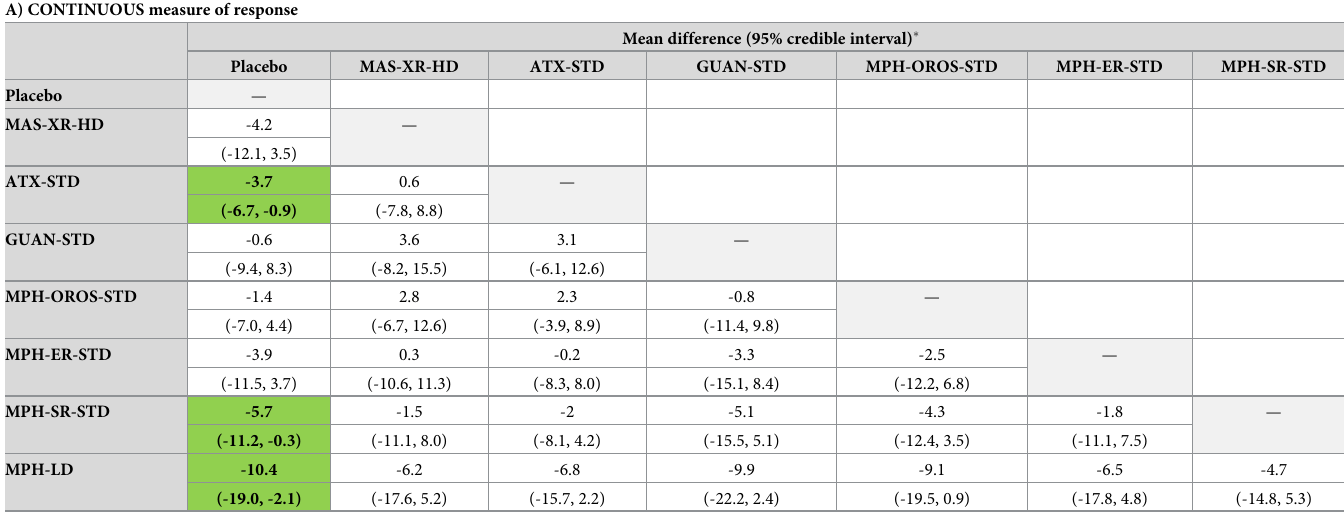
Table 5. Clinician-reported clinical response in trials with a treatment duration of at least 12 weeks–indirect comparison of ADHD